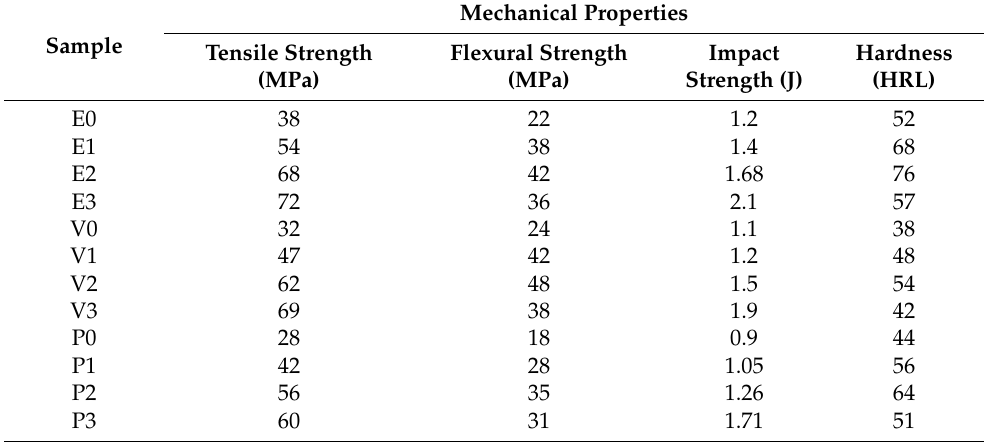
Table 5. Mechanical properties of